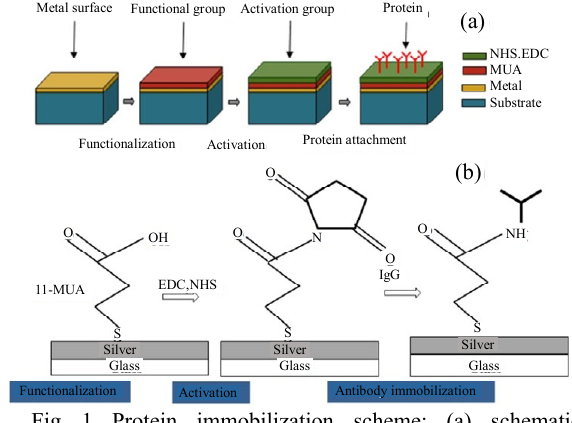
Fig. 1 Protein immobilization scheme: (a) schematic representation and (b) amine coupling